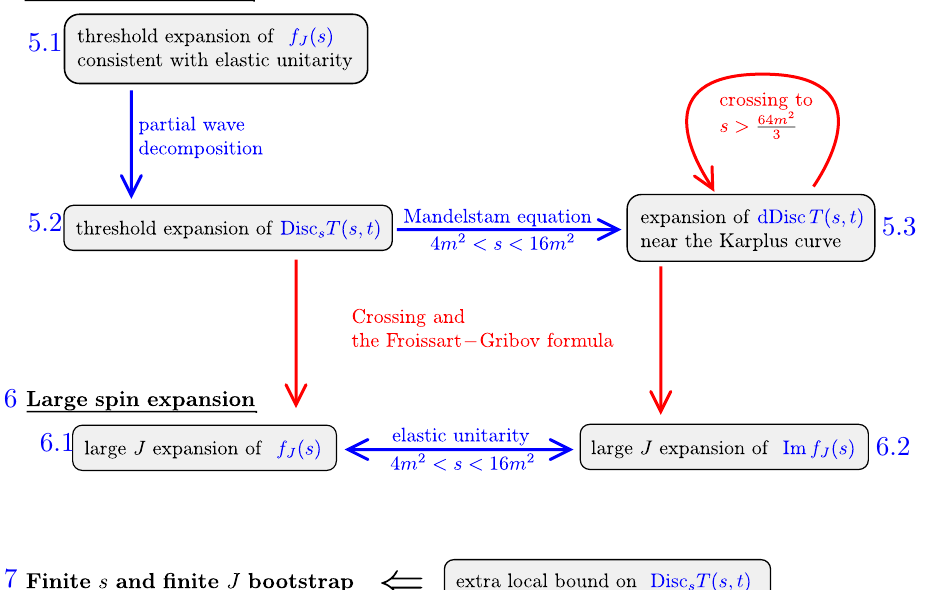
Figure 9 . The logical structure of sections 5, 6 and 7. We start in section 5 by developing the idea of the threshold expansion. We solve elastic unitarity for f J ( s ) close to s = 4 m 2 . This naturally leads to the threshold expansion both for the discontinuity of the amplitude T s ( s, t ) and its double discontinuity ρ ( s, t ) . In section 6 we use the Froissart-Gribov formula and crossing symmetry of ρ ( s, t ) to translate the threshold expansion of discontinuity T s ( s, t ) into the large J expansion of f J ( s ) and the threshold expansion of ρ ( s, t ) into the large J expansion of Im f J ( s ) correspondingly. In section 7 we give an error bound on these expansion in terms of an extra phenomenological bound on the discontinuity of the